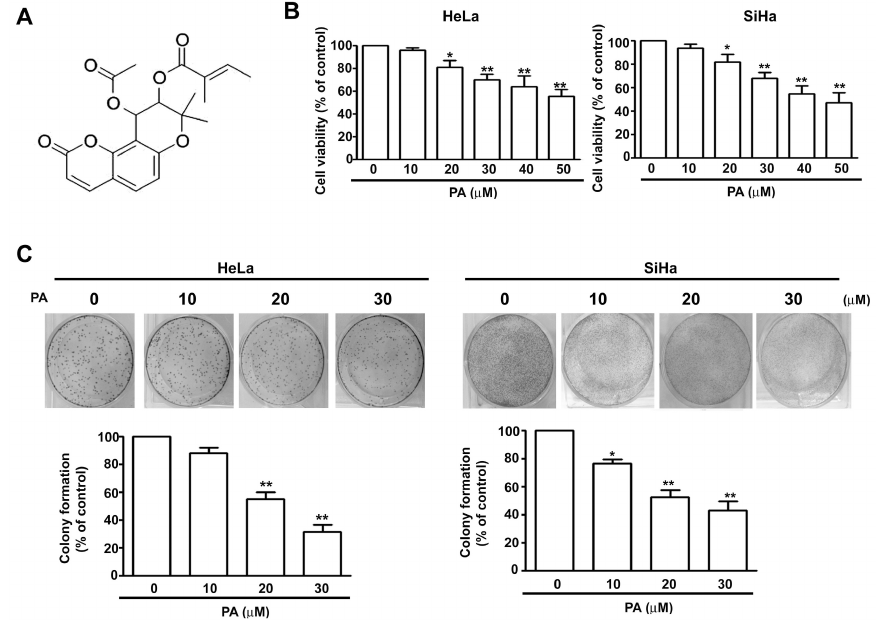
Figure 1. Effect of Praeruptorin A (PA) on viability of human cervical cancer cells. ( A ) Structure of Praeruptorin A (PA); ( B ) viability of HeLa and SiHa cells treated with various concentrations of PA (0 to 50 μ M) for 24 h, based on the 3-(4,5-Dimethylthiazol-2-yl)-2,5-diphenyltetrazolium bromide (MTT) assay; ( C ) colony formation of HeLa and SiHa cells treated with various concentrations of PA (0 to 30 μ M), with staining by crystal violet. Here and below, values are means and standard errors of 3 replicates, * indicates p < 0.05 versus control, and ** indicates p < 0.01 versus control. 2.2. PA Induces Cell Cycle Arrest at G0/G1 Phase in HeLa Cells